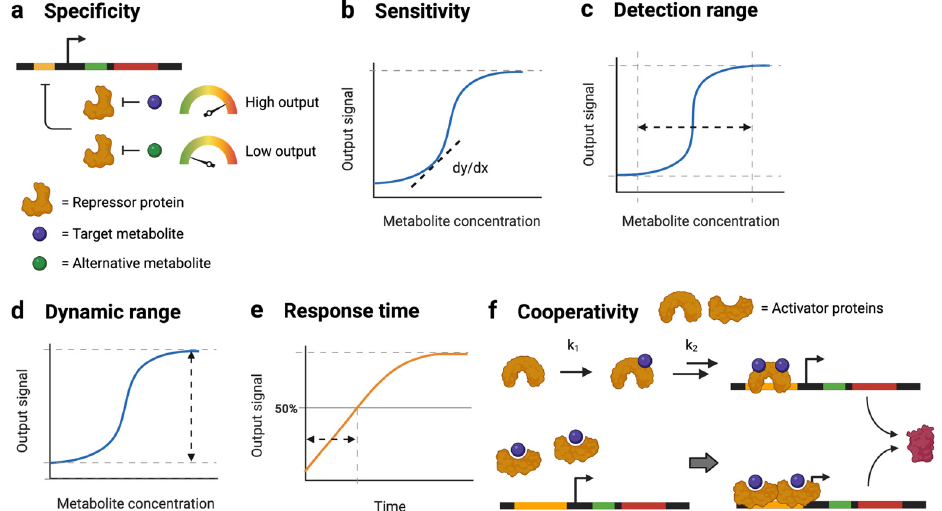
Figure 1. Biosensor performance criteria. ( a ) Specificity of a biosensor for the target metabolite compared to alternative metabolites; ( b ) sensitivity of the biosensor as represented by the slope of the sensor’s response curve; ( c ) detection range reflects the limits of the metabolite concentration detected by a sensor; ( d ) dynamic range reflects the ratio of maximal output over minimal output levels; ( e ) response time quantifies the time it takes for a sensor to reach half of its steady-state signal; ( f ) mechanisms affecting biosensor cooperativity.